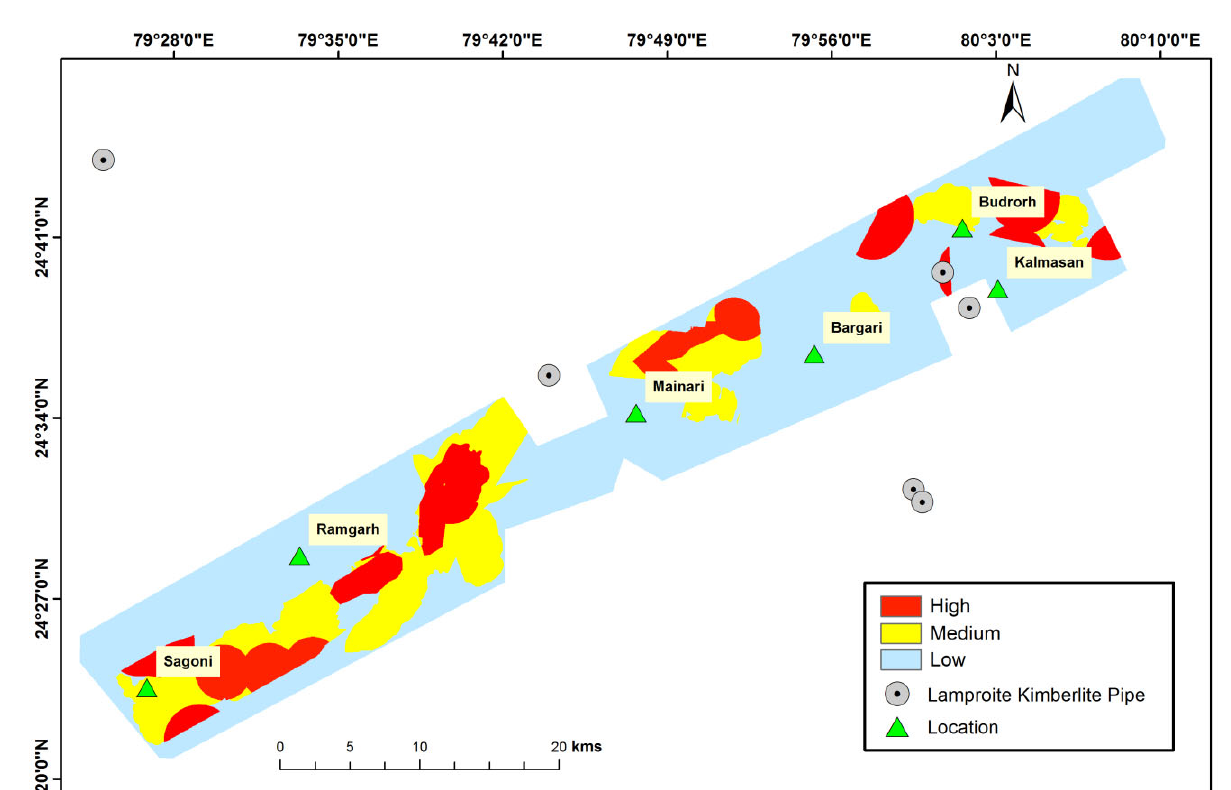
Figure 5: Prospective zones for kimberlite